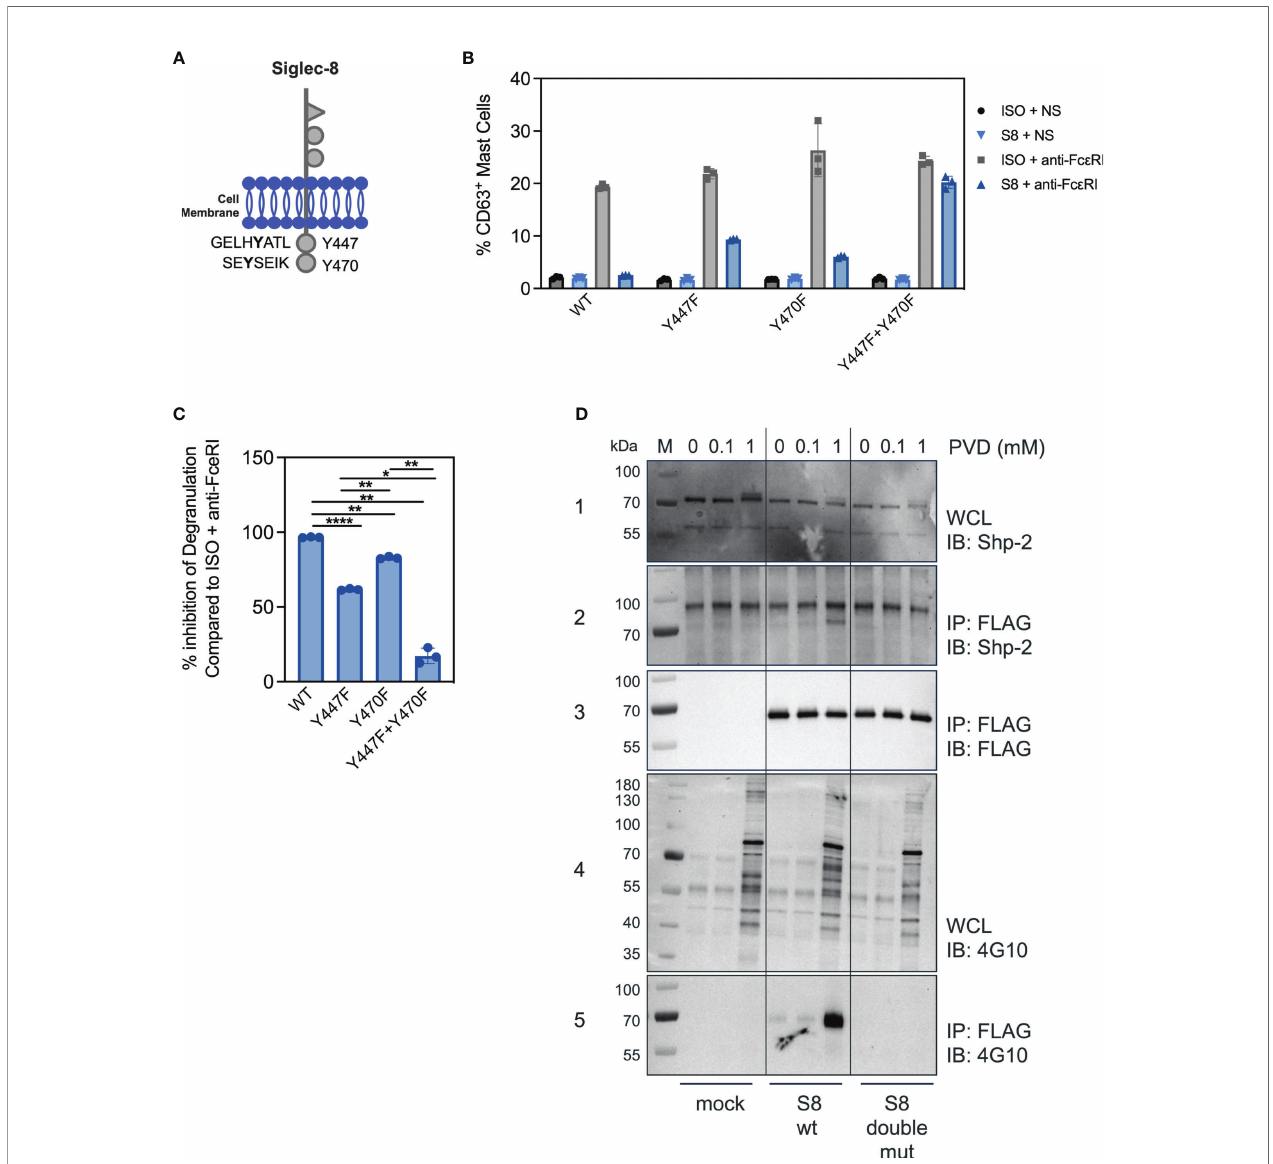
FIGURE 3 | Both ITIM motifs are required for Siglec-8 mediated inhibition. (A) Schematic of the Siglec-8 receptor with its two tyrosine residues in the context of ITIM motifs indicated. (B) Percent of CD63 positive MC in unstimulated (ISO + NS, S8 + NS), stimulated (ISO + anti-Fc e RI) and inhibited (S8 + anti-Fc e RI) MC after transfection of the indicated wild-type or mutant Siglec-8 expression constructs Data are plotted as mean ± SEM (n=3) and are representative of 3 experiments. (C) Percent inhibition of Siglec-8 mAb-treatment for each Siglec-8 expression construct was calculated compared to ISO condition. *p < 0.05, **p < 0.01, ****p < 0.0001 by one-way ANOVA test. (D) Western blot analysis of Siglec-8-Shp2 interaction. Immunoblot (IB) of whole cell lysates (WCL) or FLAG immunoprecipitations (IP) from primary MC mock transfected or with expression constructs for wild-type Siglec-8-FLAG or ITIM double mutant Siglec-8-FLAG. Cells were subjected to PVD treatment for two min and WCL were analyzed for presence of Shp-2 (panel 1) and p-Tyr (panel 4). Anti-FLAG IPs were analyzed for presence of Shp-2 (panel 2), Siglec-8-FLAG (panel 3) and p-Tyr (panel 5). Experiments were performed 2-3 times for con fi